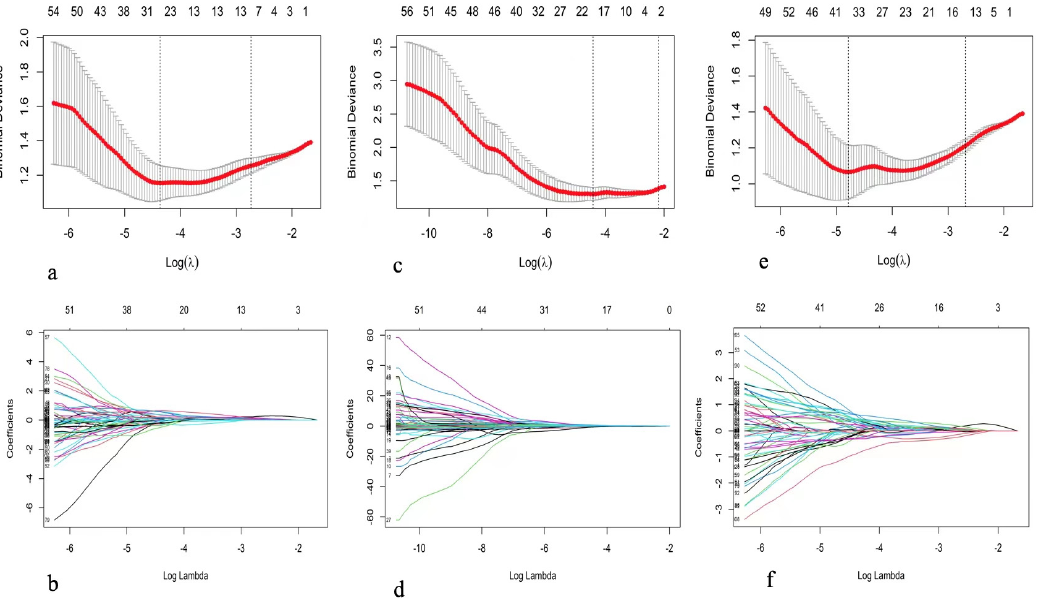
Figure 2. The lasso plots for radiomics feature selection: ( a , b ) for T2WI, 10 features were selected when the λ 1se = 0.06478, ( c , d ) for DWI, 4 features were selected when the λ 1se = 0.11225, and ( e , f ) for T2WI + DWI sequences, 13 features were selected when the λ 1se = 0.06787. Table 3. The selected radiomics features of T2WI, DWI, and T2WI + DWI models.